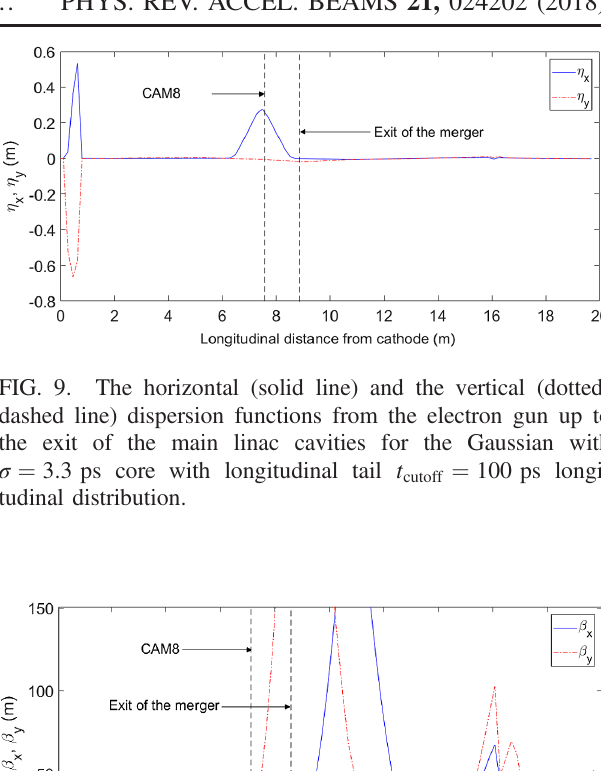
TABLE IV. Input parameters for simulations.